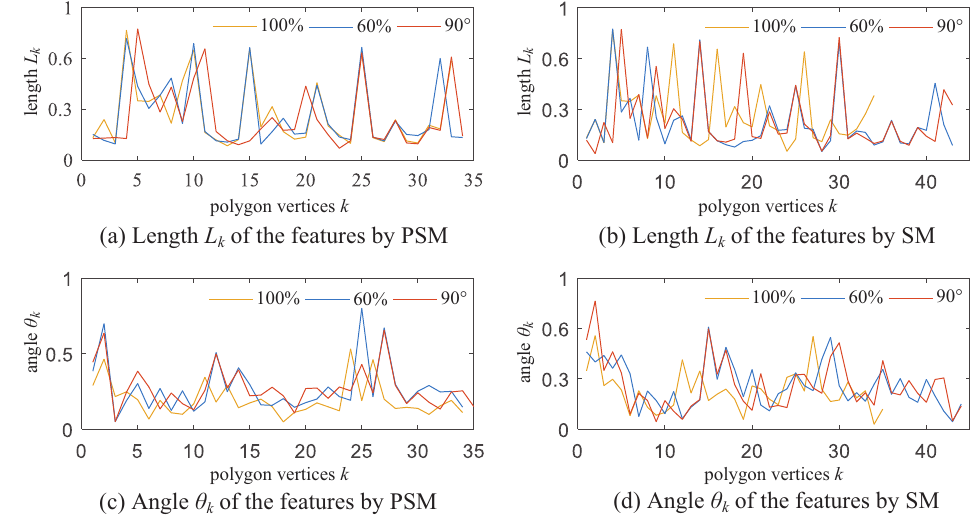
Figure 12. Features of the angle and